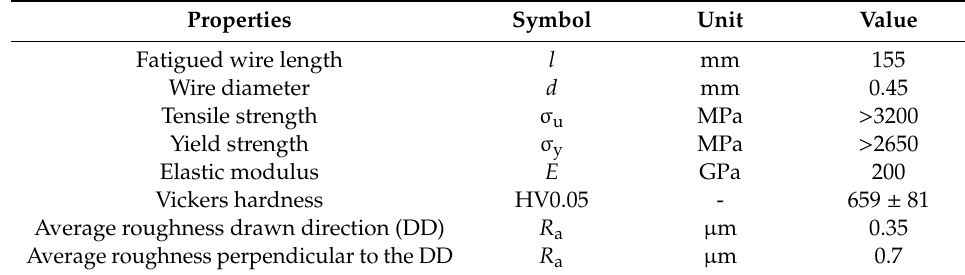
Table 2. Geometrical, mechanical and surface